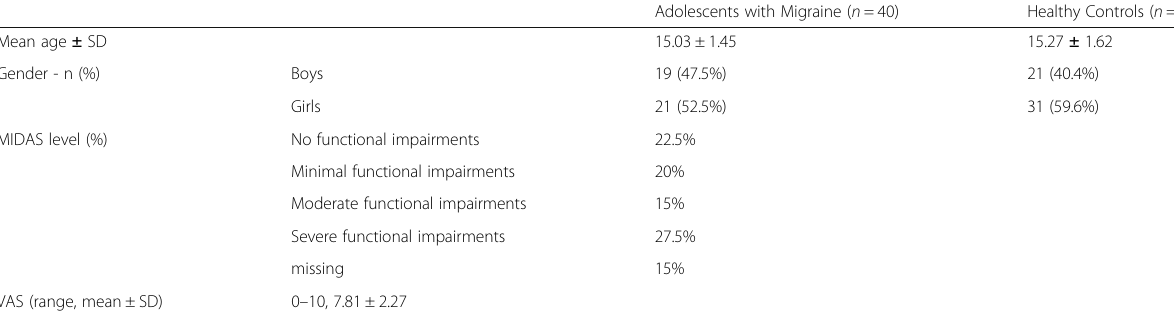
Table 1 Participants ’ health and demographic